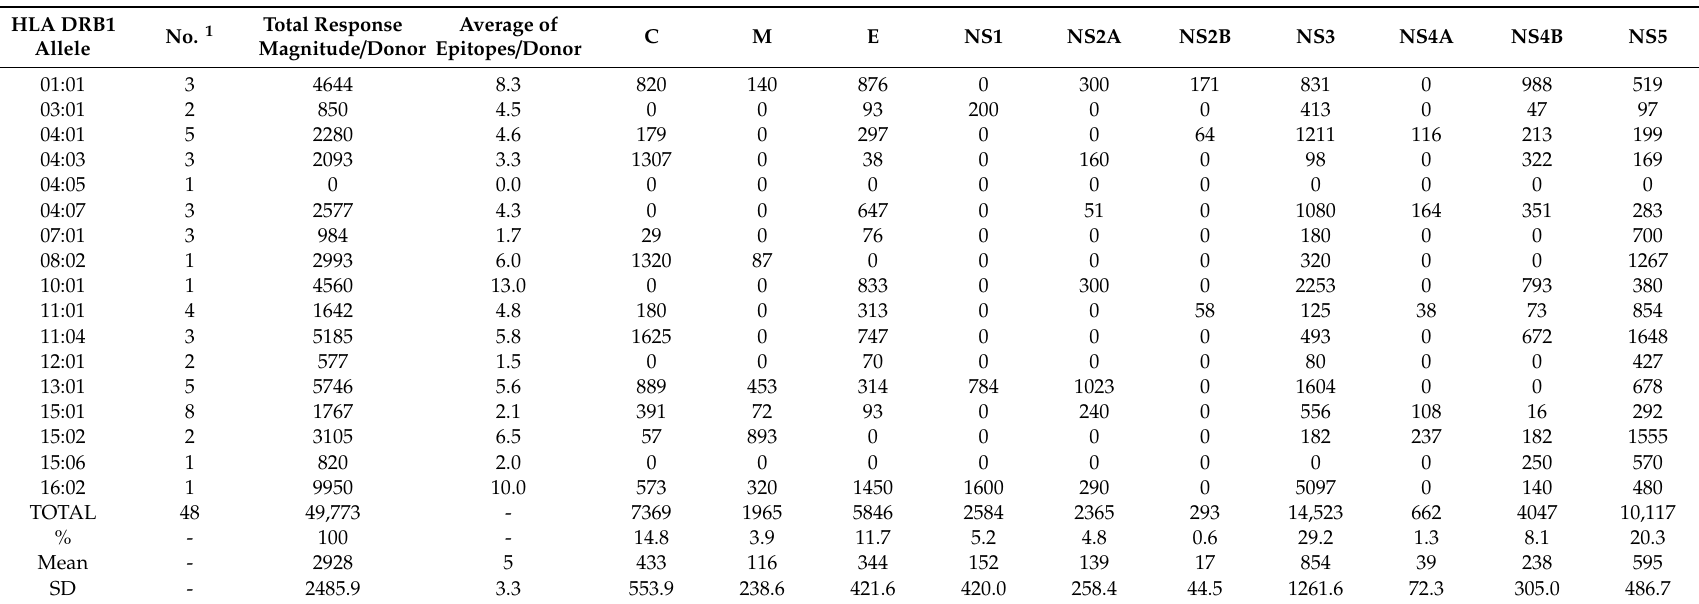
Table 2. CD4 + T cell immunoreactivity against YFV epitopes in PBMCs from YF-17D